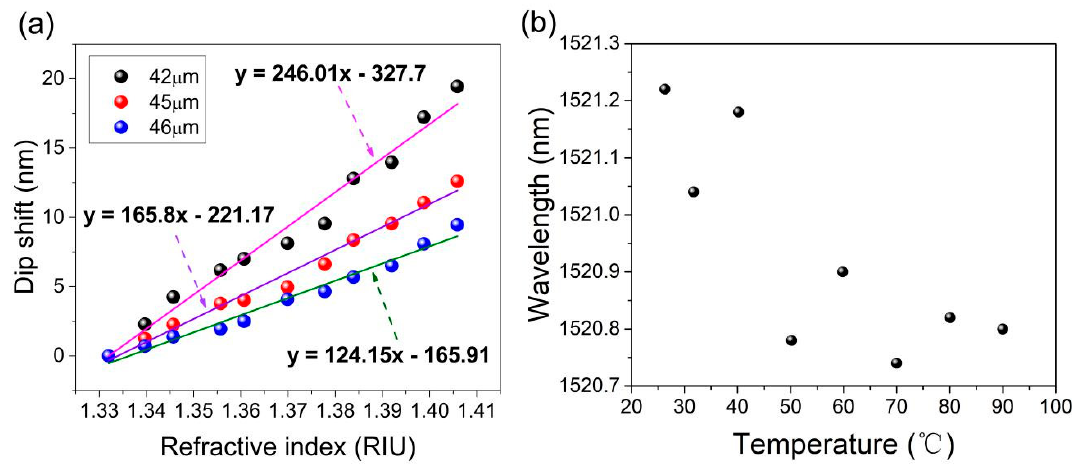
Figure 8. ( a ) The RI sensitivities of the MZI with different etched diameters; ( b ) The temperature response of the RI sensor.